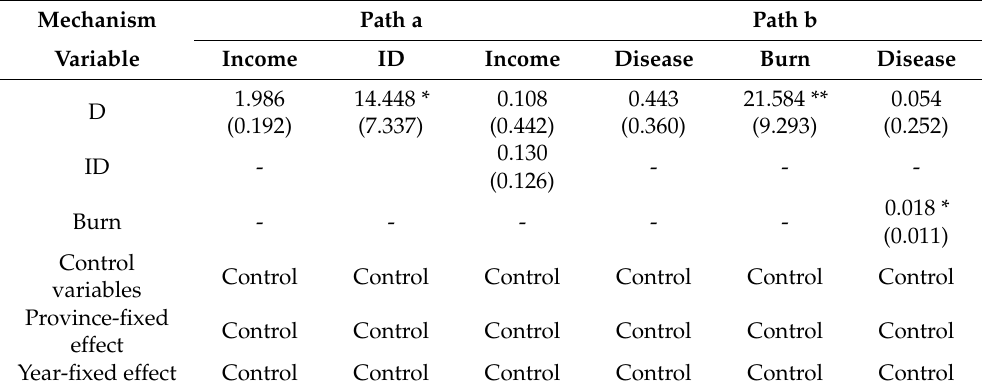
Table 11. Stepwise test regression coefficients.